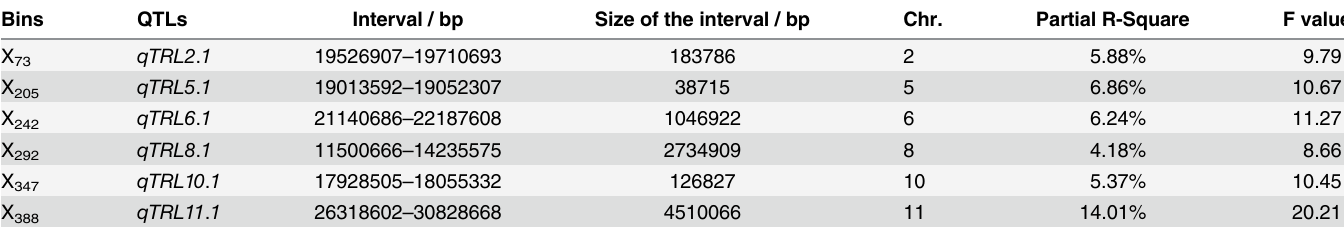
Table 4. QTLs mapping of